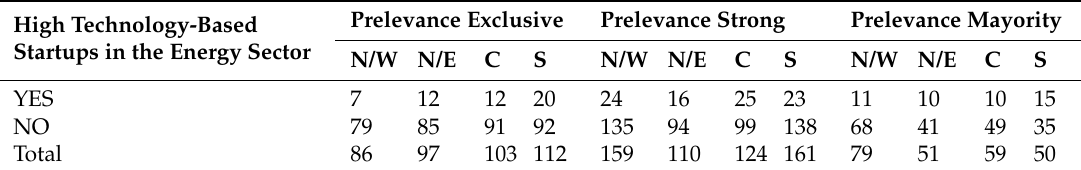
Table 14. Type of Italian woman startups (WSU) to geographical macroarea and Italian companies that operate, or not, in the high technology energy